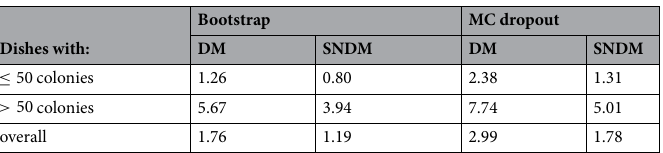
Table 1. Average uncertainties of predictions for the test dataset within the DM and the SNDM models in the bootstrap and MC dropout approaches (as presented in Fig. 4). Uncertainties averaged in a group of less (more) crowded dishes with ≤ 50 ( > 50 ) colonies and overall.